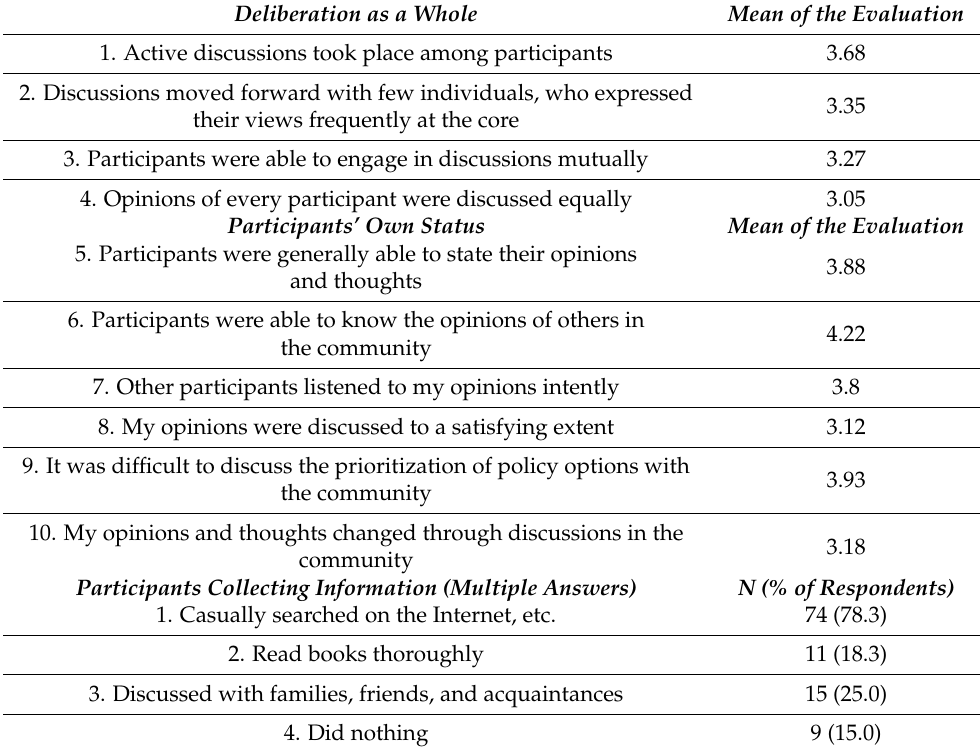
Table 4. Evaluation of the online